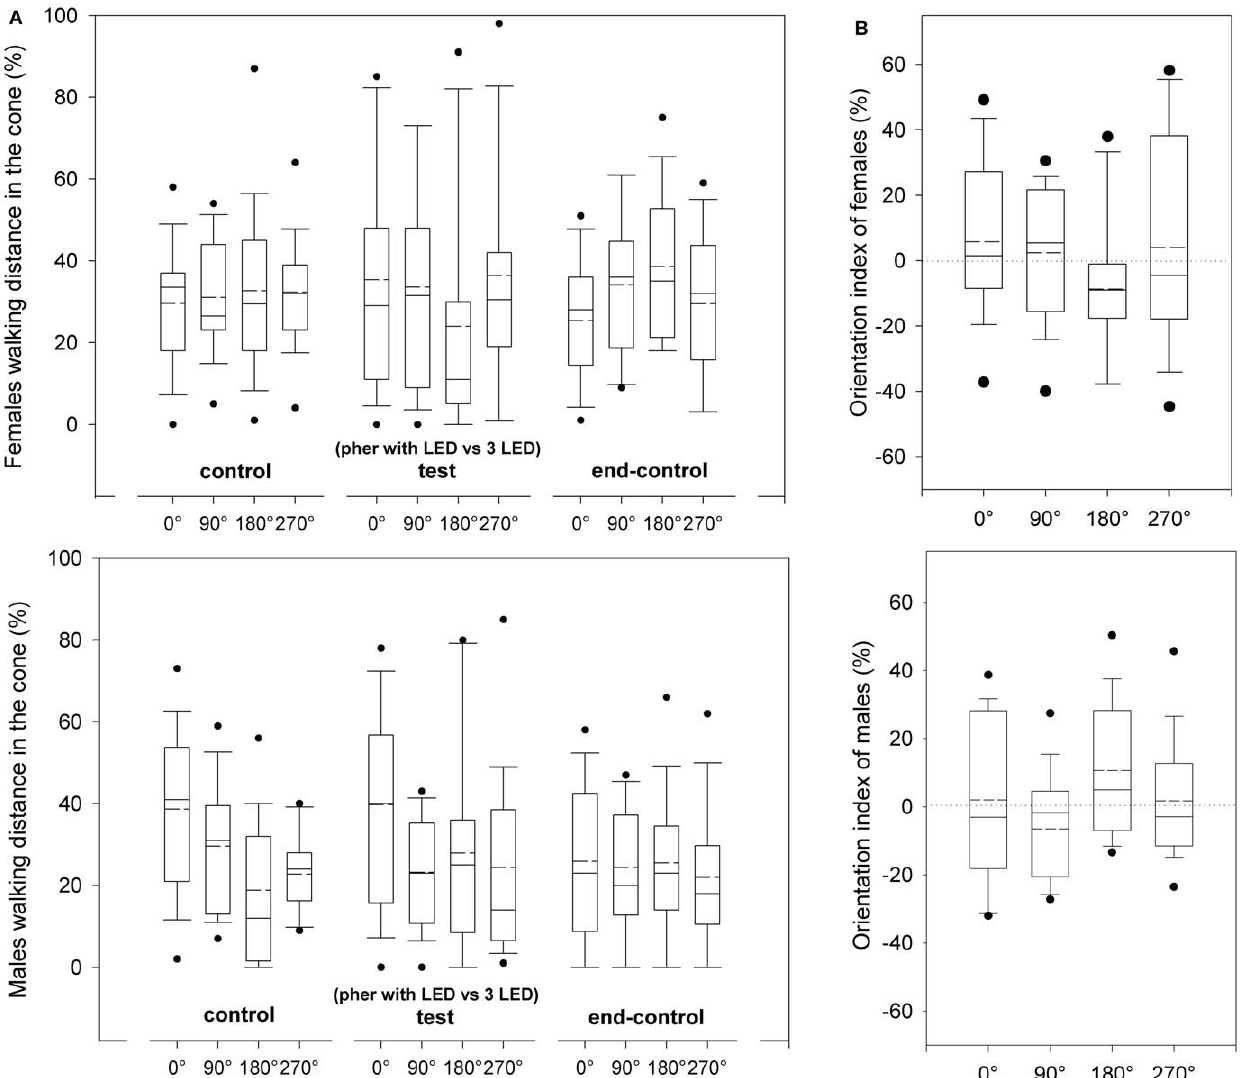
Figure 4. Orientation of Colorado potato beetle to aggregation pheromone in the presence of yellow light. Orientation behaviors of female and male CPBs stimulated simultaneously with a male produced aggregation pheromone ( S )-CPB I in an air stream and four opposite LED beams of yellow light, two perpendicular and two parallel to the air stream (pher vs. 4 LED). a. Proportion of distance covered during the three experimental periods (control, test and end-control) in each of four 120 u cones projected to 0 u , 90 u , 180 u and 270 u respectively. b. Orientation index calculated as the proportion of distance covered in each cone during the test period minus the proportion of the distance covered in each cone during the first control period. In the boxplots, the line within a box mark the median, the segmented line within a box mark the mean, the lower and upper boundary lines of a box indicate the 25 th and 75 th percentiles, bars below and above indicate the 10 th and 90 th percentiles, respectively, and the points represent data beyond these